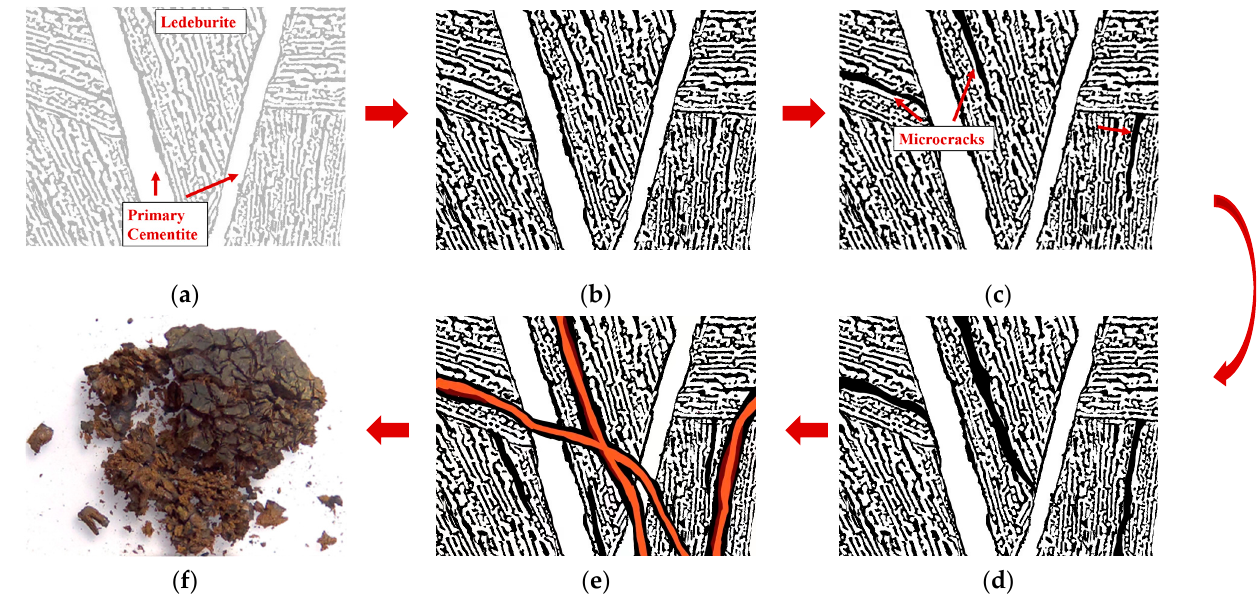
Figure 9. Schematic diagrams of the development of internal matrix fractures in the brittle pulverization of the iron pot from the “Nanhai I” shipwreck. ( a ) Initial State. ( b ) Beginning of cor- rosion. ( c ) Generation of microcracks. ( d ) Development of fissures. ( e ) Acceleration of corrosion. ( f )